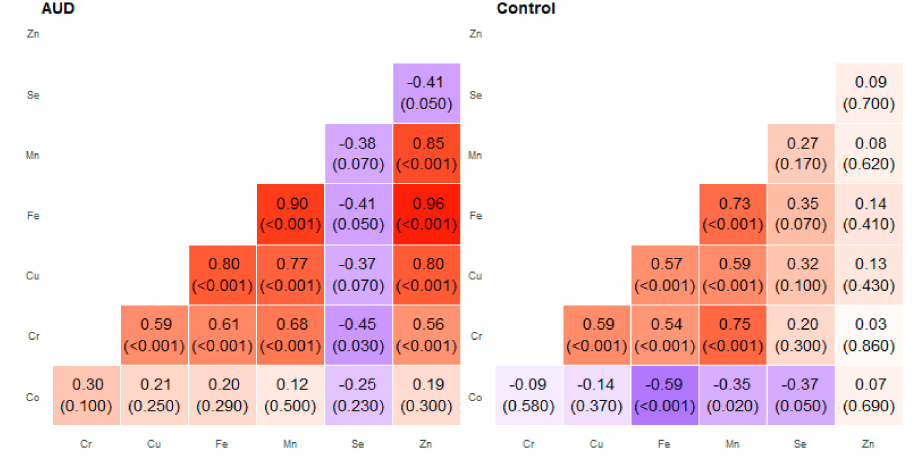
Figure 7. Correlation matrix of Spearman coe ffi cient charts in the frontal part of the insula region in the alcohol use disorder and control